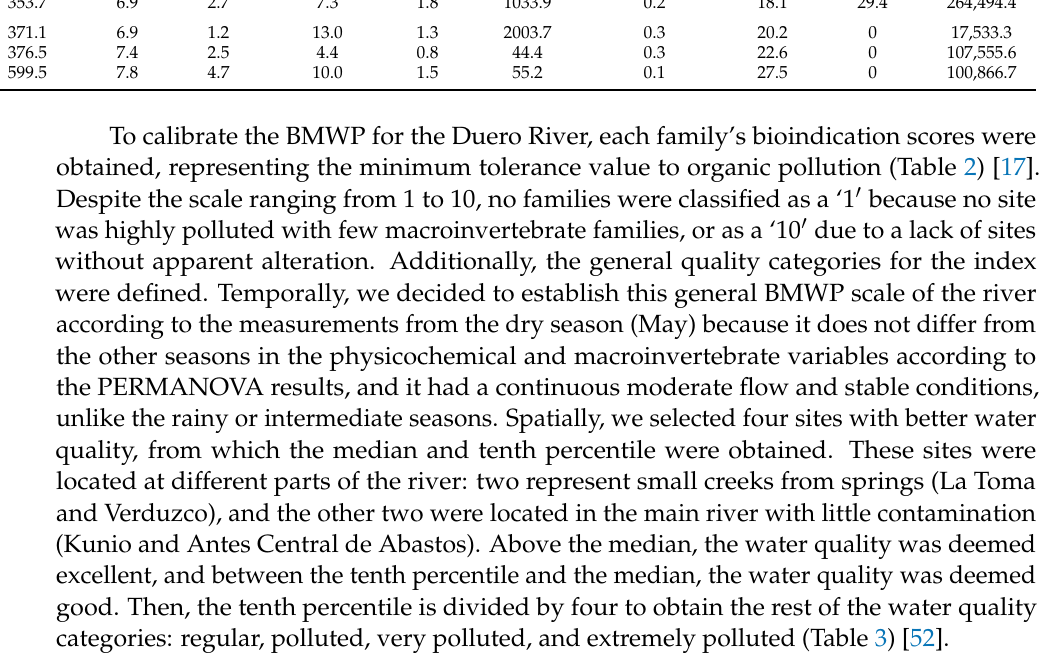
Sites Temperature ◦ C